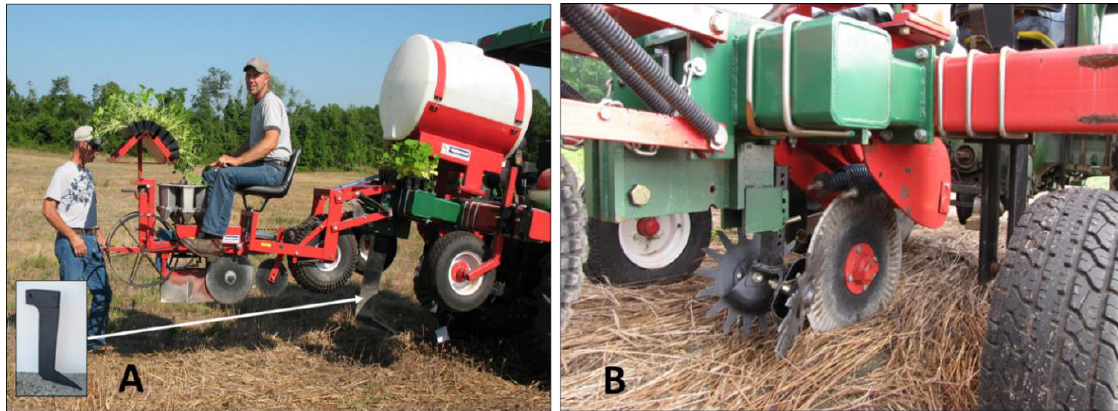
Figure 4. ( A ) RJ Equipment ® no-till transplanter, with the additional custom designed sub-frame to accommodate a custom subsoiler shank (subsoiler used is pointed by arrow) for a single combined subsoiling and transplanting operation. ( B ) Row cleaners were mounted for cover crop residue management.